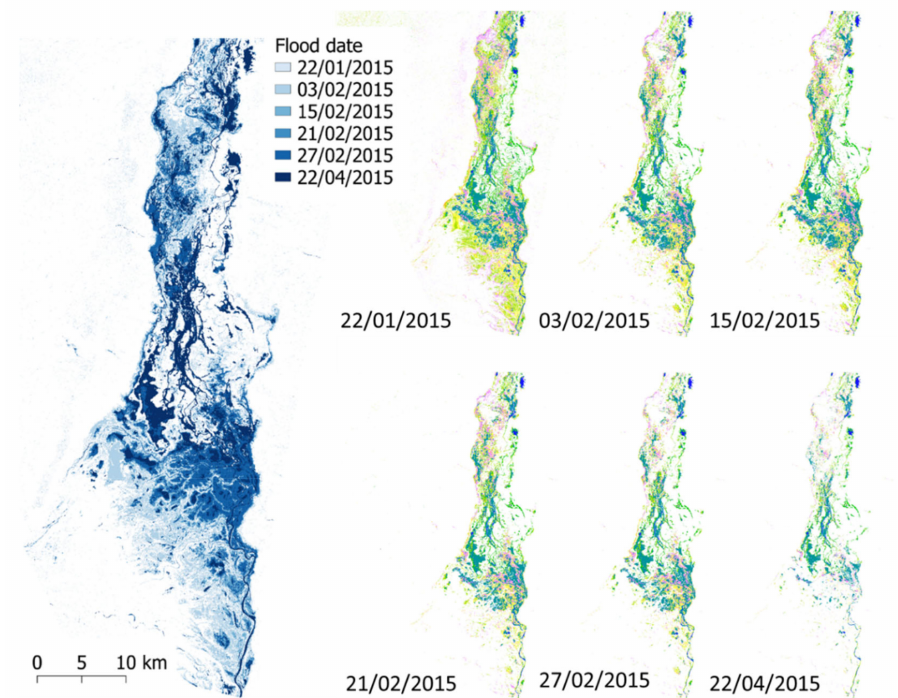
Figure 2. Left: multi-temporal flood map for an area of the Shire basin, obtained by Sentinel-1 images. Areas with darker colors are flooded for longer periods, thus depicting the shrinking of the flooded surface from the first (22 January 2015), up to the last flood date (27 February 2015) reported in the legend. Darkest areas are covered by permanent water (at the post-event date of 22 April 2015). Right: maps of flooded areas on each of the 6 S1 acquisition dates, with colors corresponding to the CORINE land cover classes (shown in Figure 1).